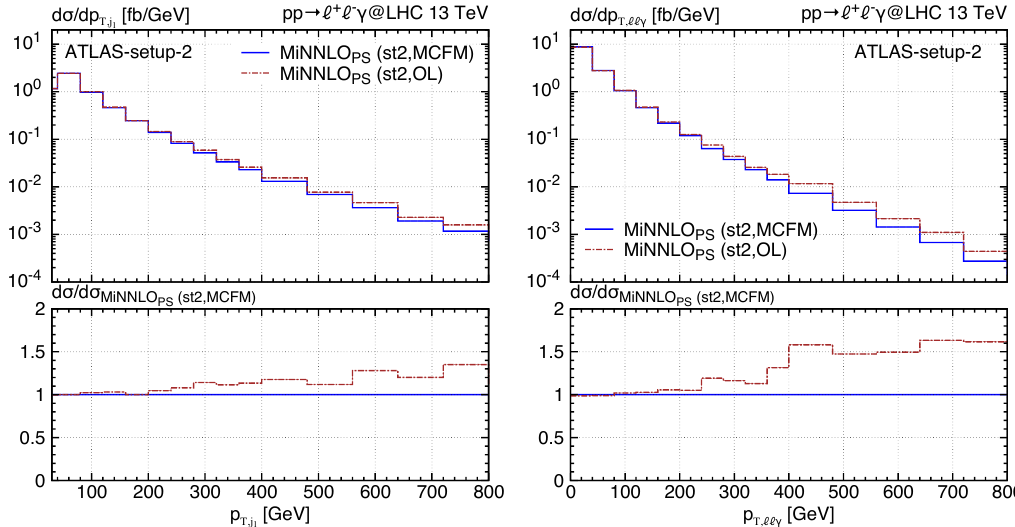
Figure 11. Comparison of MiNNLO PS predictions using MCFM (blue, solid) and using Open- Loops (brown, dash-dotted) for the distribution in the transverse momentum of the leading jet (left plot) and of the Zγ system (right plot) at POWHEG stage 2 in ATLAS-setup-2 (see section